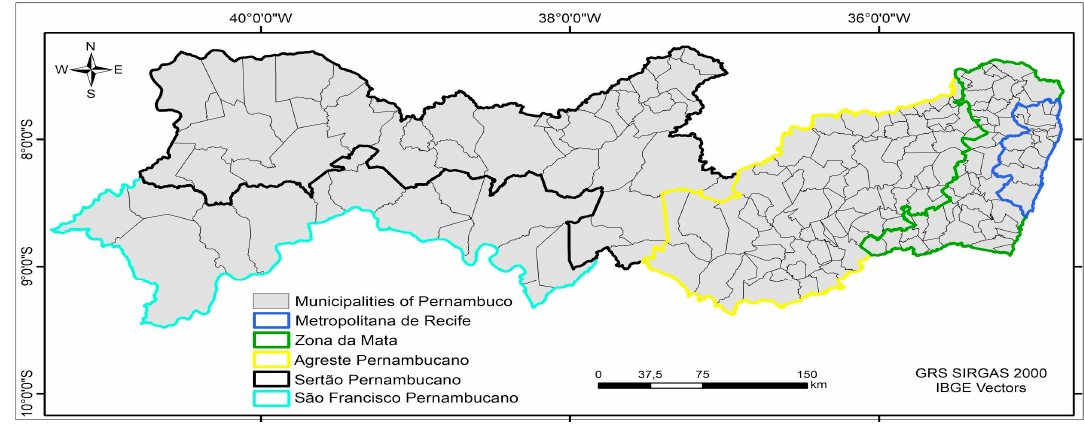
Figure 2. Location of Pernambuco’s mesoregions.